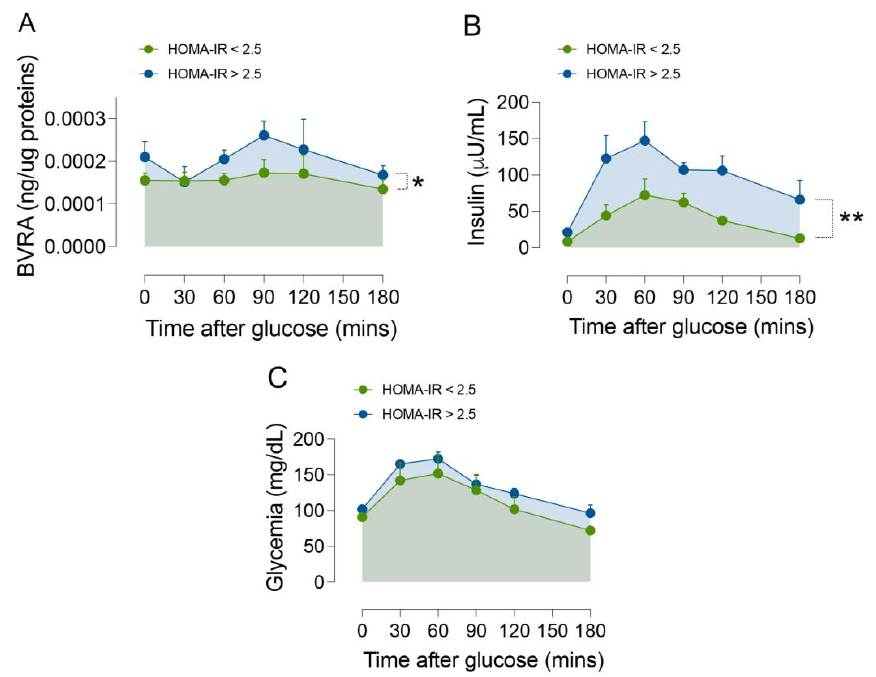
Figure 3. Changes of ( A ) BVRA protein levels (ng/μg of proteins ) evaluated in PBMCs along with mean changes of ( B ) insulin (μU/mL) and ( C ) glycemia (mg/dL) circulating levels in the subjects of mean changes of ( B ) insulin ( µ U/mL) and ( C ) glycemia (mg/dL) circulating levels in the